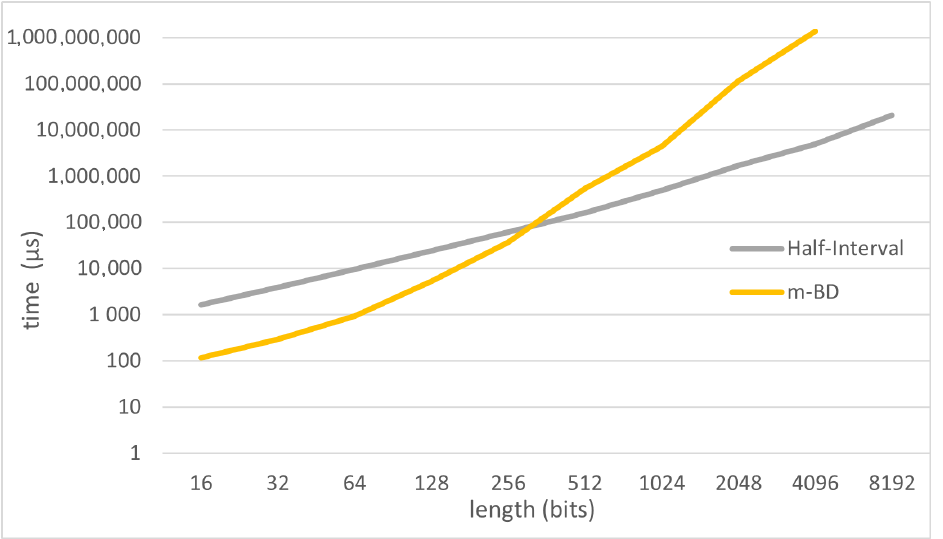
Figure 4. Comparison between half-interval search and m-BS algorithms.